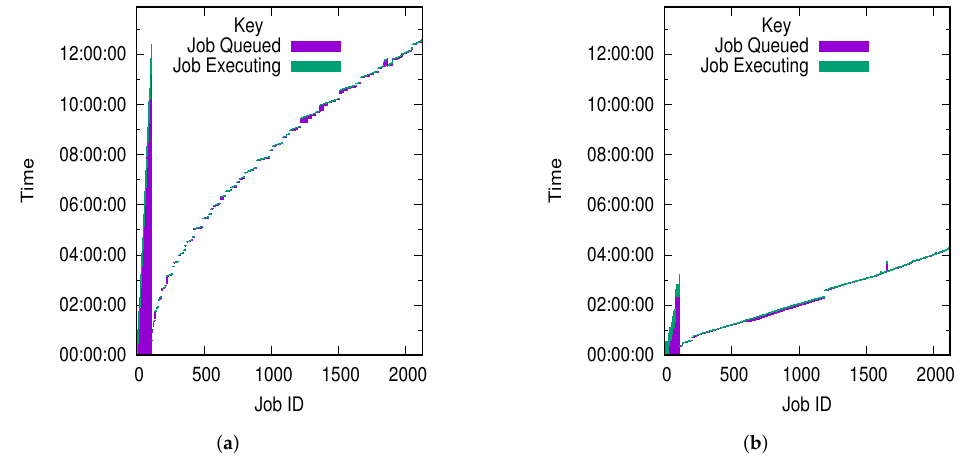
Figure 6. Execution of a 1.5 degree workflow on a 1 node vs. 6 node cluster: ( a ) 1.5 degree Montage on a small cluster; ( b ) 1.5 degree Montage on a large